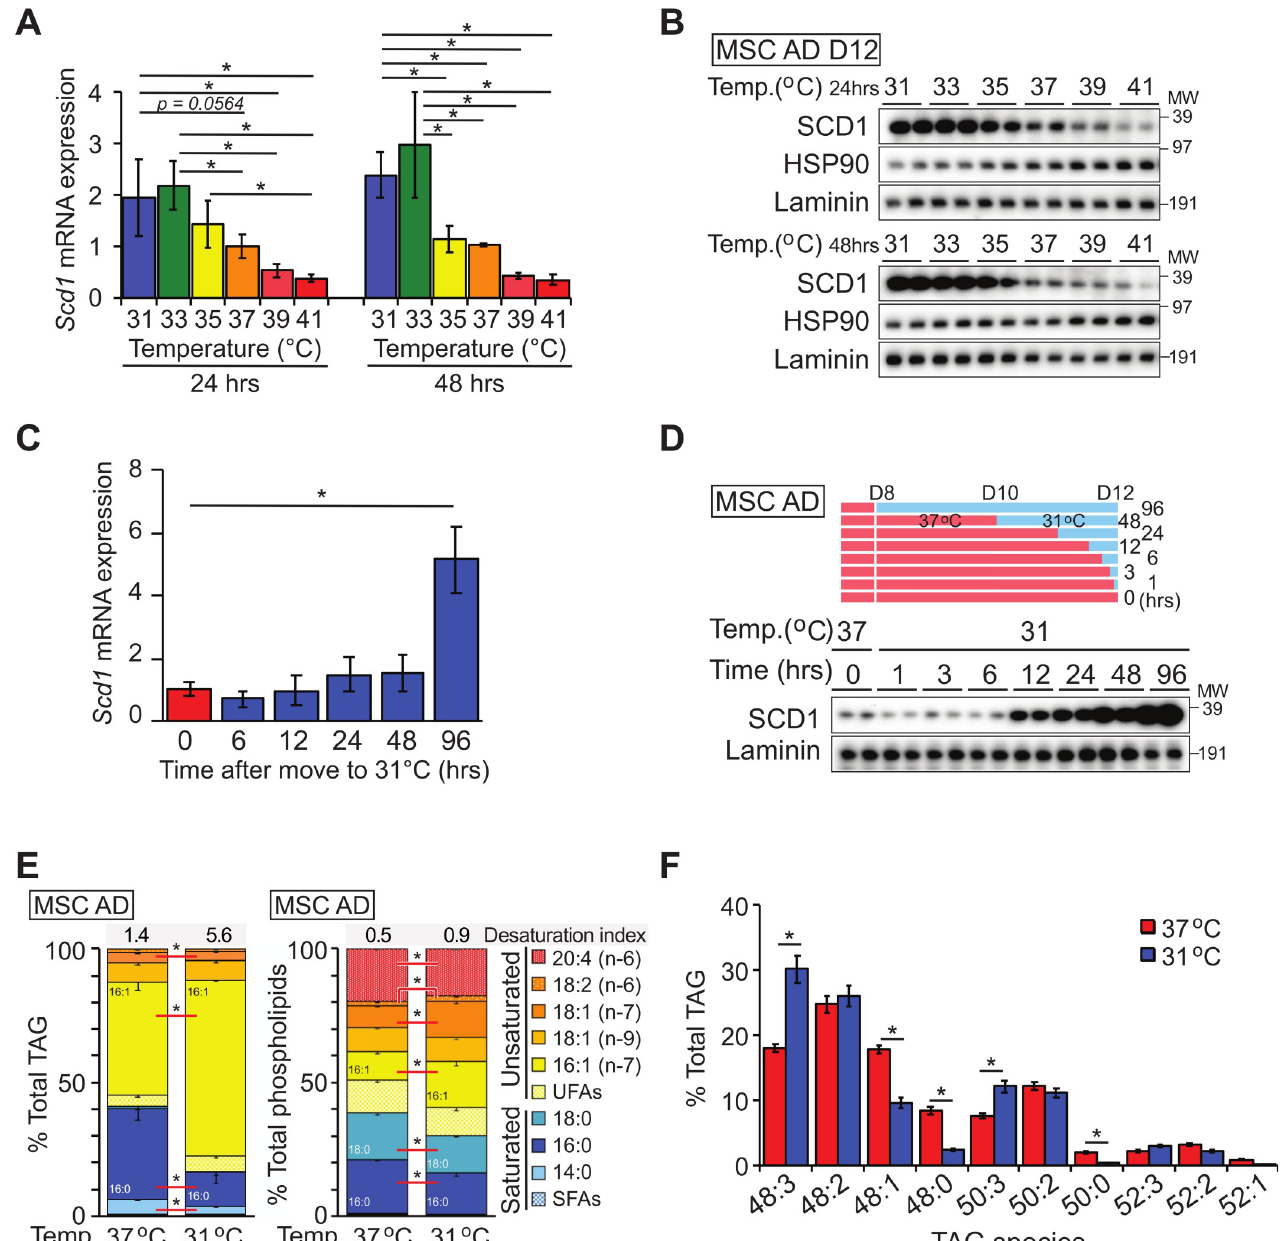
Fig 2. Adaptation of cultured adipocytes to cool temperatures induces expression of SCD1 and proportion of unsaturated lipids in TAG and phospholipid fractions. ( A, B ) Cultured adipocytes were incubated for 24 or 48 hours at indicated temperatures before collecting samples. Expression of SCD1 mRNA ( A ) and protein ( B ) were evaluated by qPCR and immunoblot, respectively. Scd1 mRNA was normalized to the geometric mean value of Hprt , Tbp , Gapdh , Rpl32 , Rpl13a , B2m , and Rn18s and is expressed as fold change relative to 37˚C control ( n = 4). ( C, D ) SCD1 mRNA ( C ) and protein ( D ) expression in adipocytes cultured at 31˚C for indicated times. SCD1 mRNA was normalized to Hprt mRNA and is expressed as fold change relative to 0-hour control ( n = 4). ( E ) Lipid composition of TAG and phospholipid fractions in adipocytes adapted to 31˚C for 11 days ( n = 6). Desaturation index at top of graph is (16:1 + 18:1)/ (16:0 + 18:0). ( F ) TAG species in adipocytes adapted to 31˚C for 11 days ( n = 4). Data are presented as mean ± SD. � p < 0.05. Uncropped western blots are provided in S1 Raw Images, and numerical data for all graphs are provided in S2 Data. qPCR, quantitative polymerase chain reaction; SCD1, stearoyl-CoA desaturase-1; TAG, triacylglycerol.